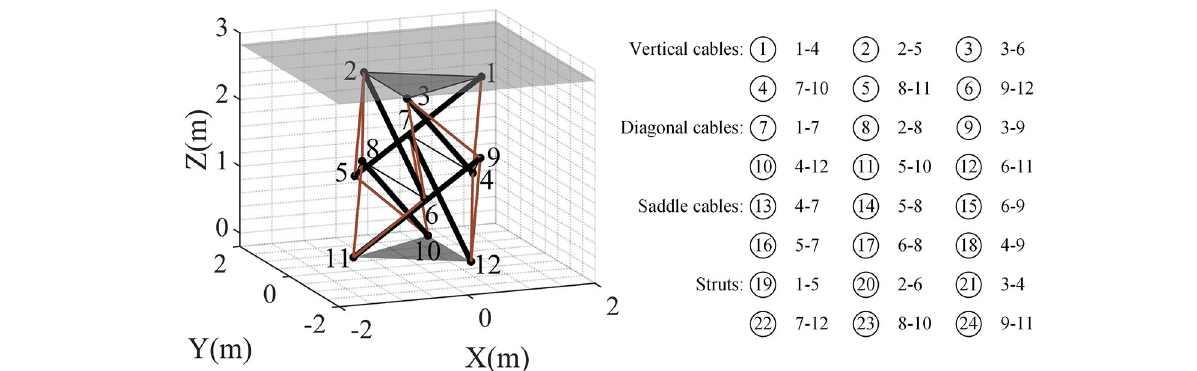
Frontiers in Built Environment |